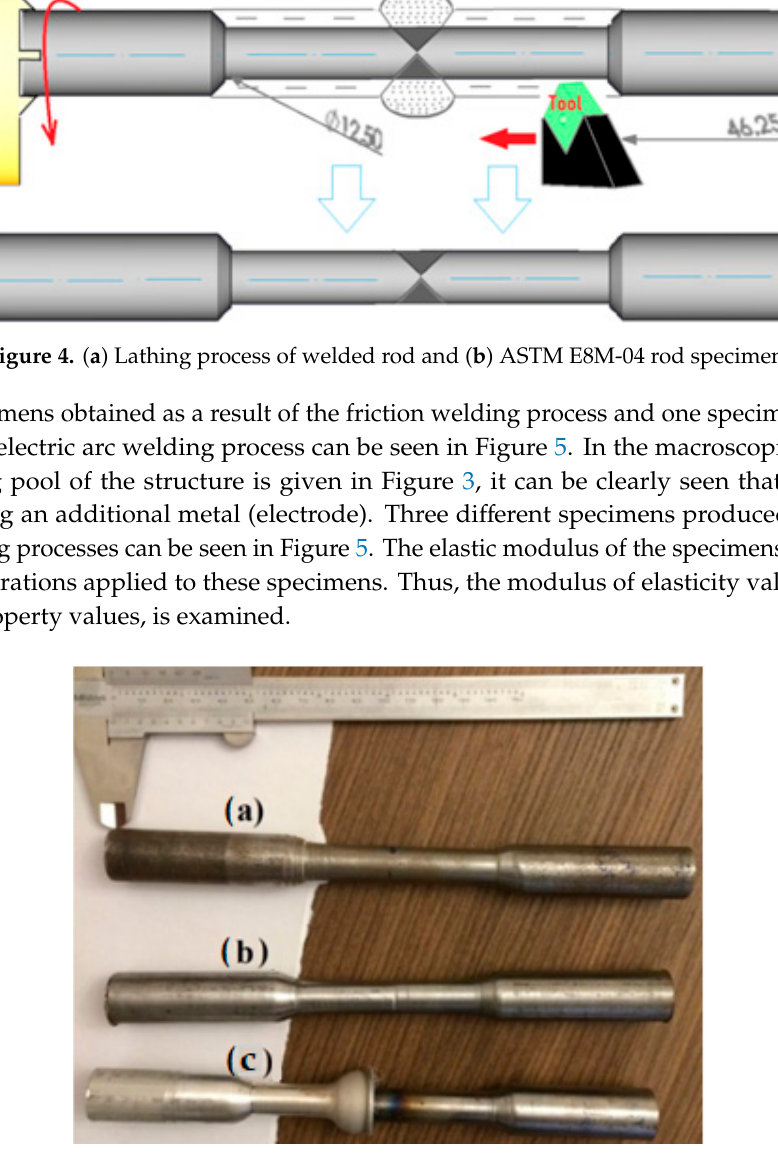
Figure 5. ( a ) Arc welded specimen, ( b ) steel–steel friction welded specimen and ( c ) aluminum–steel